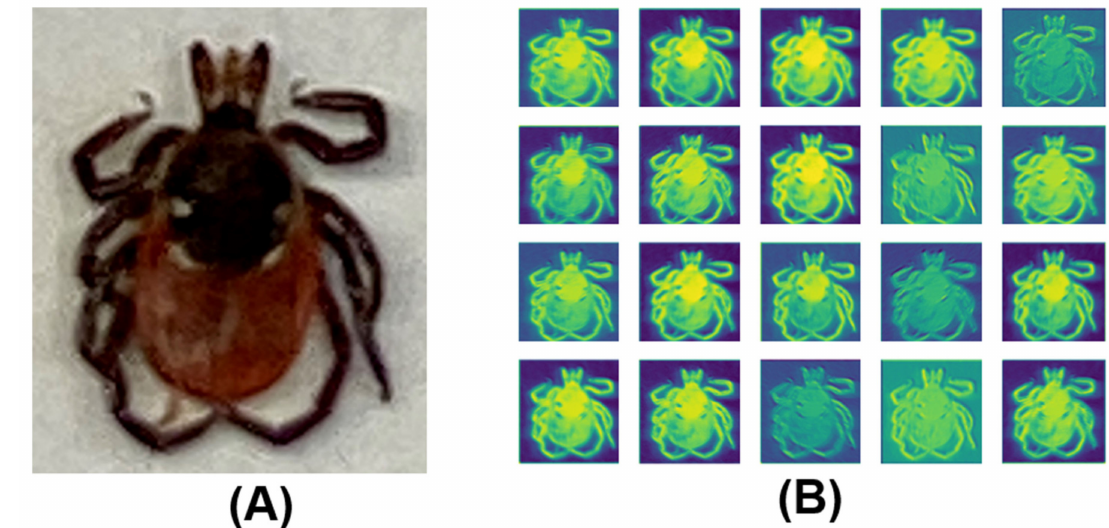
Figure 4. Tick photo and its visualization of activations. ( A ) A photograph of a female tick that was taken using our smartphone. ( B ) Visualization of activation in the first convolution layer of 64: 2: Color: 80–20, demonstrating that the model has learned to efficiently activate against the morphologic characters of the female tick ( A